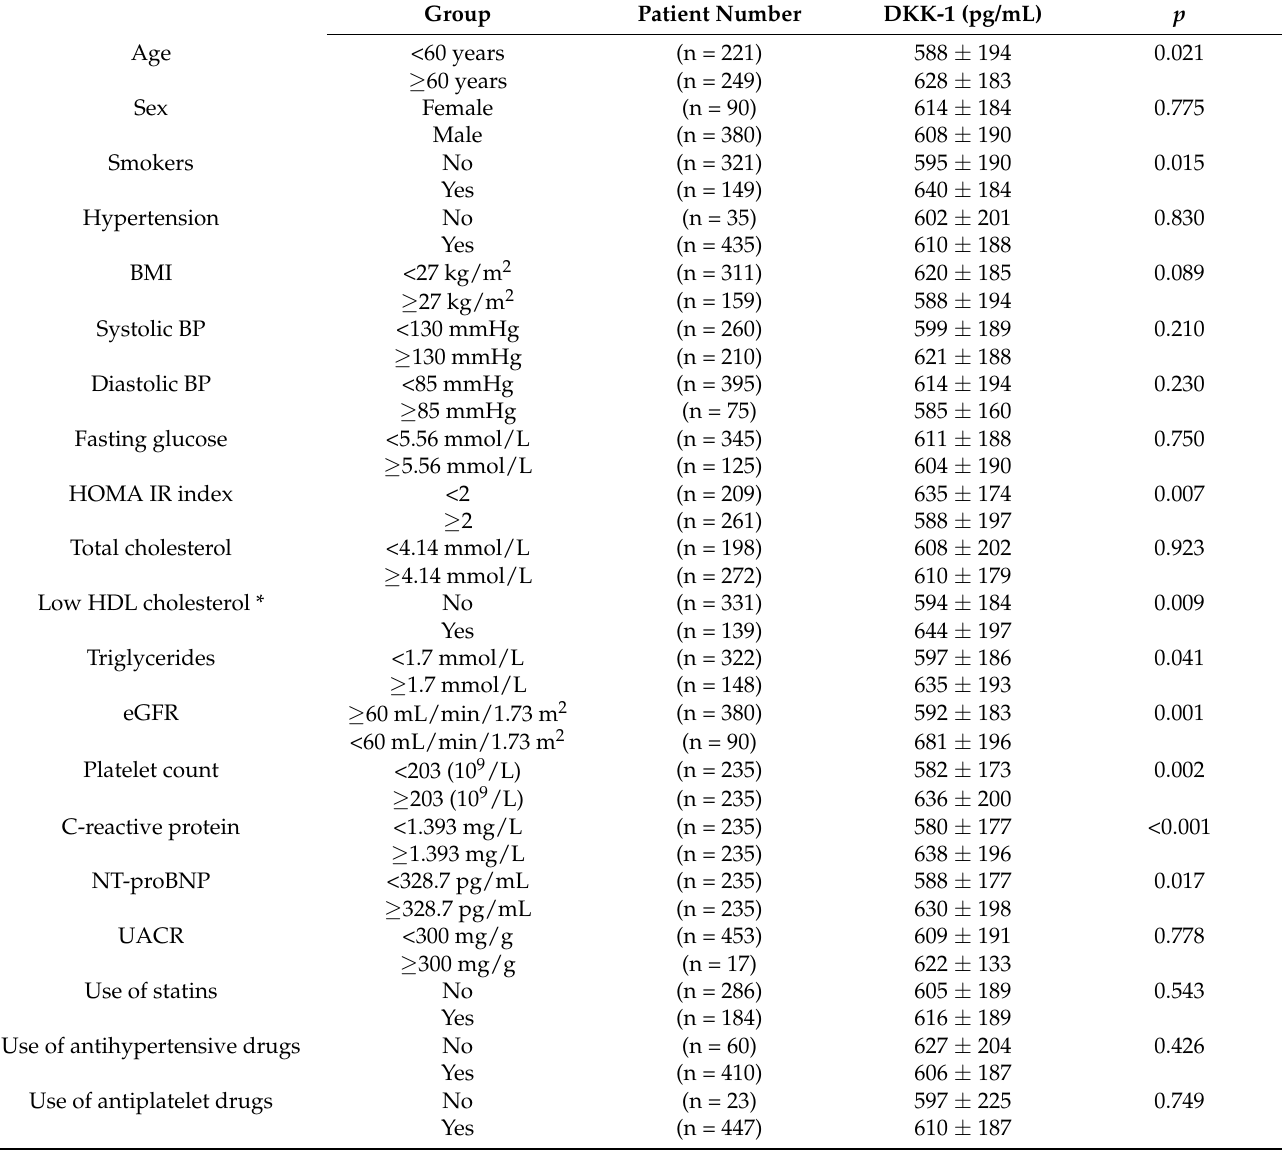
Table 2. Plasma DKK-1 concentrations between the groups categorized by risk